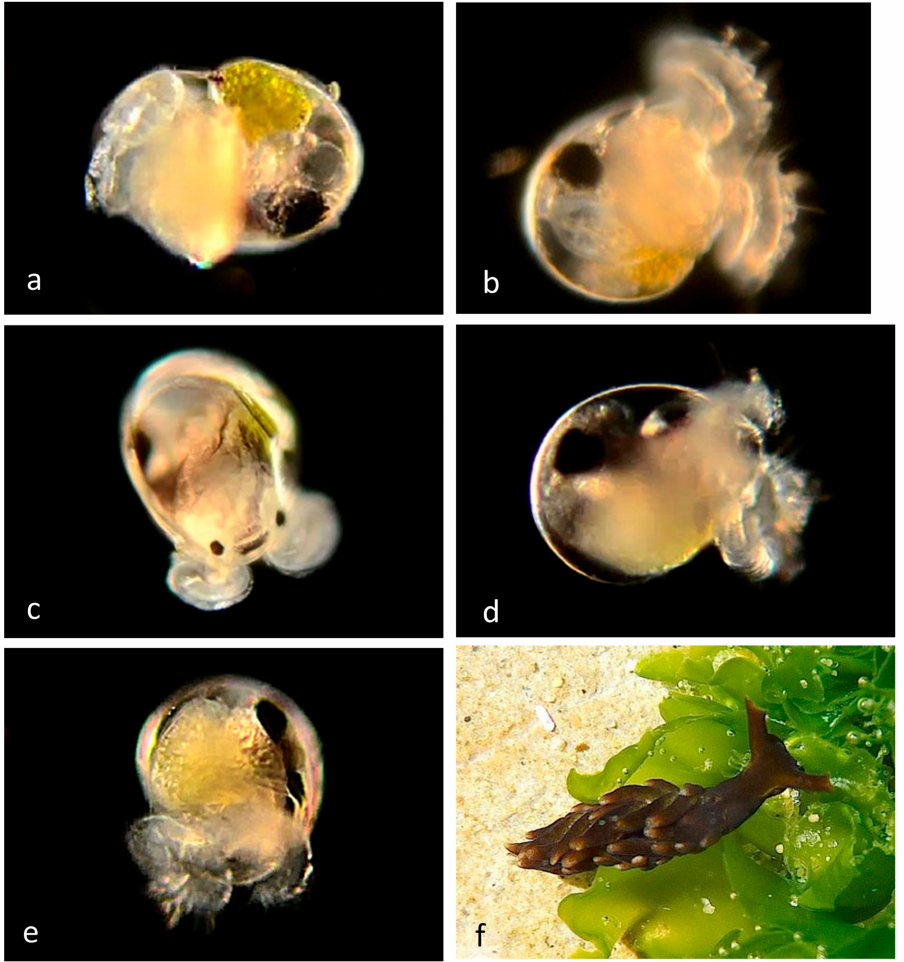
Figure 11. Family Hermaeidae. Aplysiopsis enteromorphae . ( a ) Veliger larva BIOUG01229-H05 from Newport Pier. ( b ) Veliger larva CCDB-32329 H01 from Balboa at Coral. ( c ) Veliger larva BIOUG01205-H12 from Via Lido, Lido Island. ( d ) Late veliger BIOUG01229-H03 from Balboa at Coral. ( e ) Late veliger BIOUG01229-H04 from off Newport Pier. ( f ) Adult (no DNA barcode) from Rocky Bight, Crystal Cove State Park, Orange County,